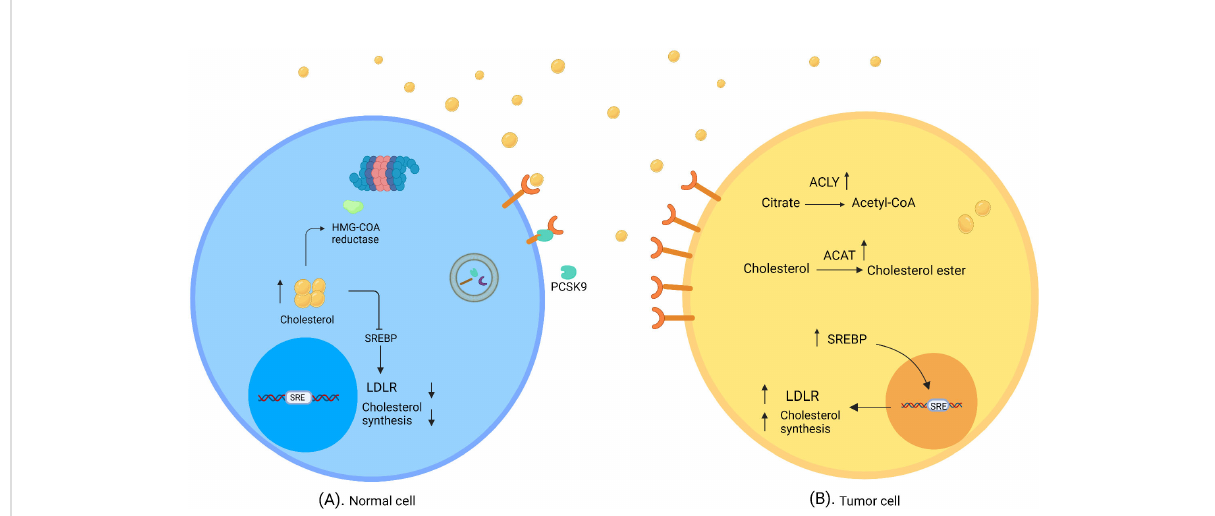
FIGURE 1 Normal and tumor cells in cholesterol-rich environment. (A) In normal cells, a high concentration of cholesterol triggers regulatory mechanisms of cholesterol synthesis and uptake, which downregulate SREBP and degrade HMG- CoA reductase. (B) Tumor cells evade feedback mechanisms in a cholesterol-rich environment. SREBP shows high activity; thus LDLR expression and/or cholesterol synthesis are elevated. ACAT catalyzes the synthesis of cholesterol ester; therefore, cholesterol accumulates in tumor cells. ATP citrate lyase converts citrate to acetyl- CoA and induces fatty acid synthesis (created with